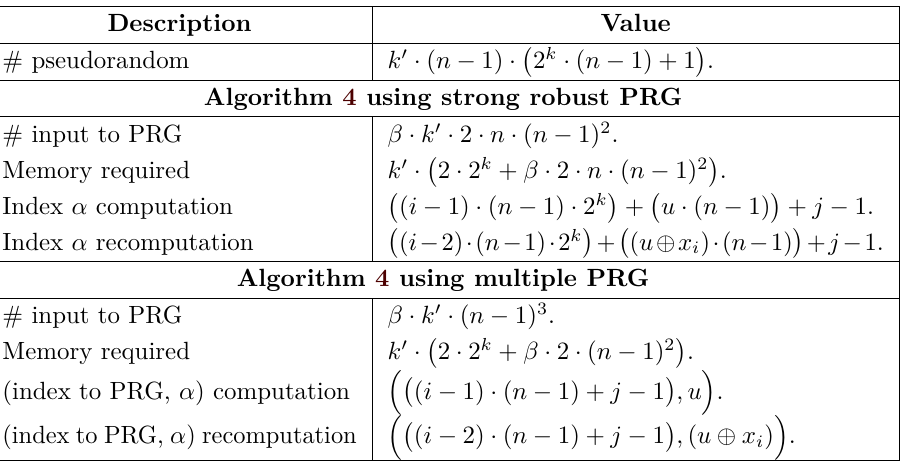
Table 2: Summary of the total number of bits of pseudorandom values, true random values, memory required per ( k, k 0 ) S-box along with formulas for index α computation and recomputation of Algorithms 5 and 6 using robust PRG and multiple PRG approaches, respectively. Here, i represents the shift index, u is the row index and j represents the column